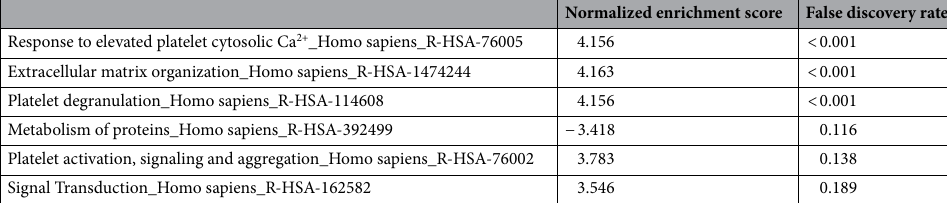
Table 4. Significantly enriched pathways for post-transplant patient survival. Significance evaluated by phenotype permutation False Discovery Rate < 0.2. Sorted by FDR.